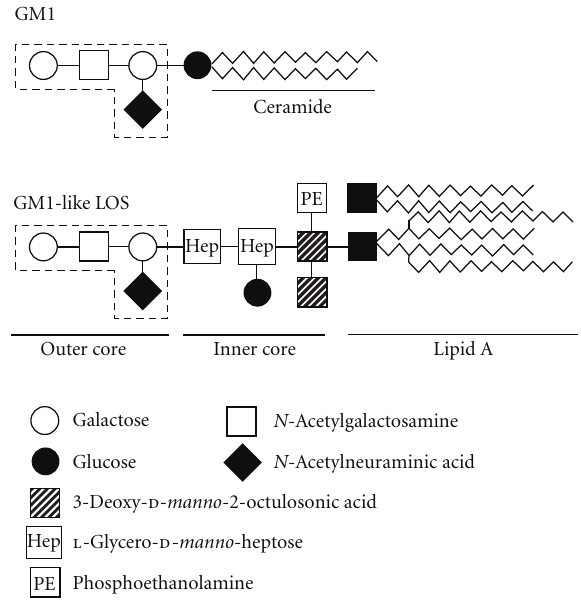
Figure 1: Carbohydrate mimicry between gangliosides and Campy- lobacter jejuni lipo-oligosaccharides (LOSs). The terminal tetrasac- charide of GM1-like LOS is identical to that of GM1 (shownby dash